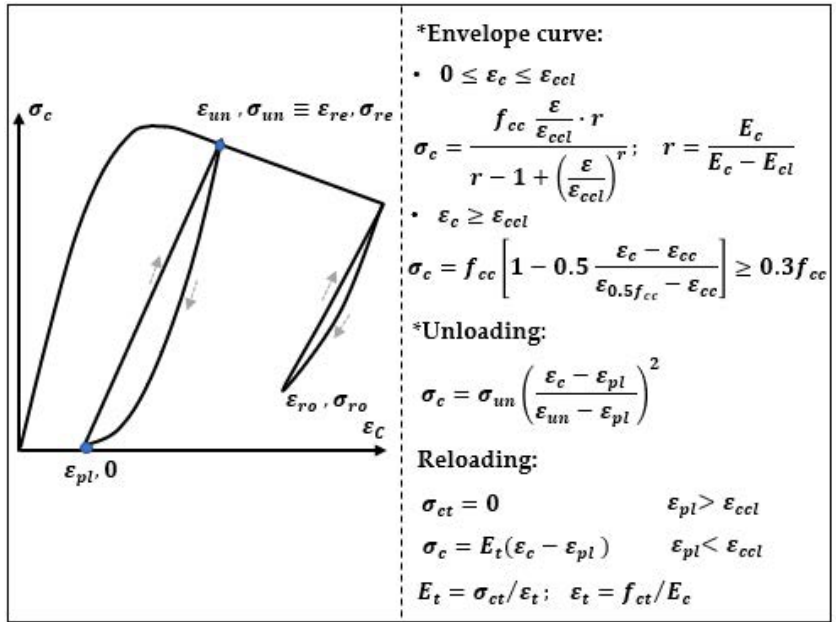
Figure 8. Concrete model according Konstantinidis et al.